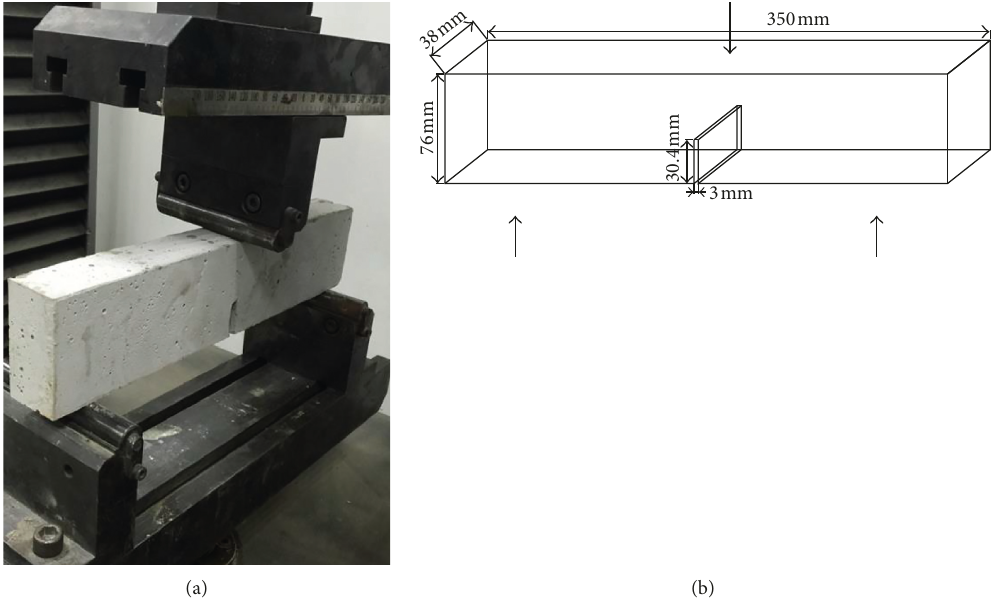
Figure 3: The setup of three-point bending test: (a) the tested specimens; (b) the dimension of specimens (all dimensions in